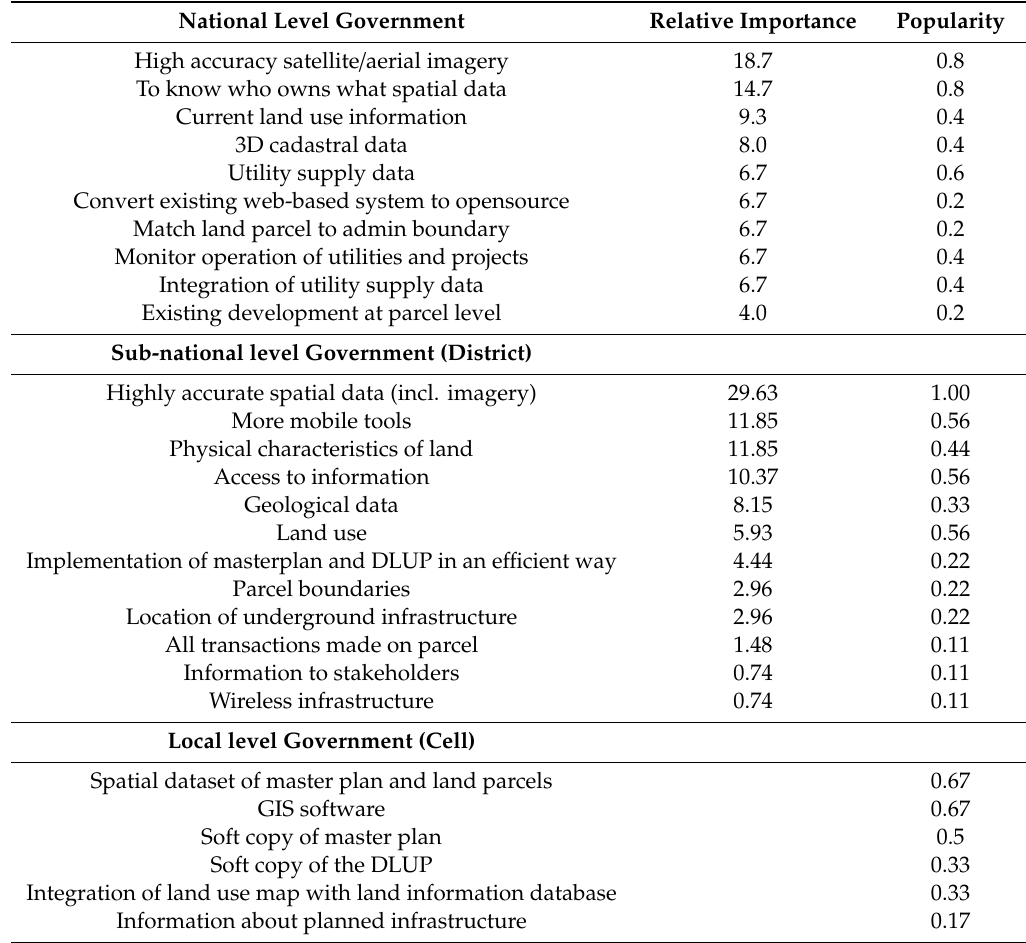
Table 6. Land information needs as identified by government stakeholders.